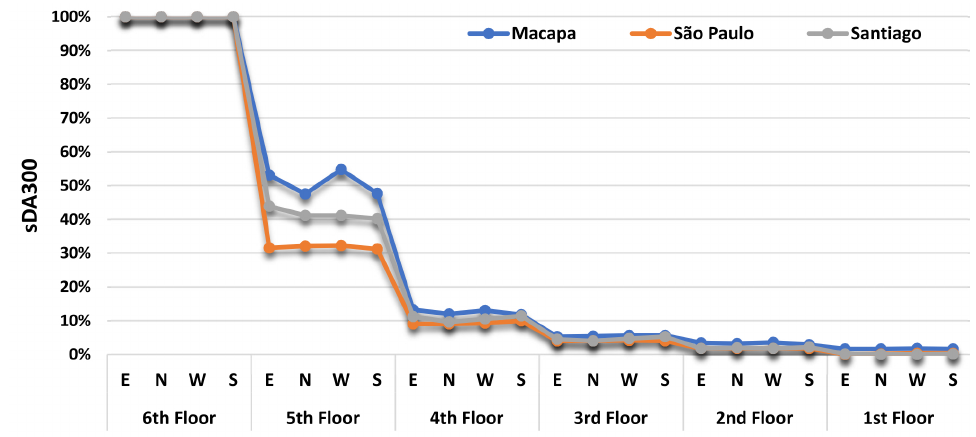
Figure 2. sDA values for the base model at different latitudes.